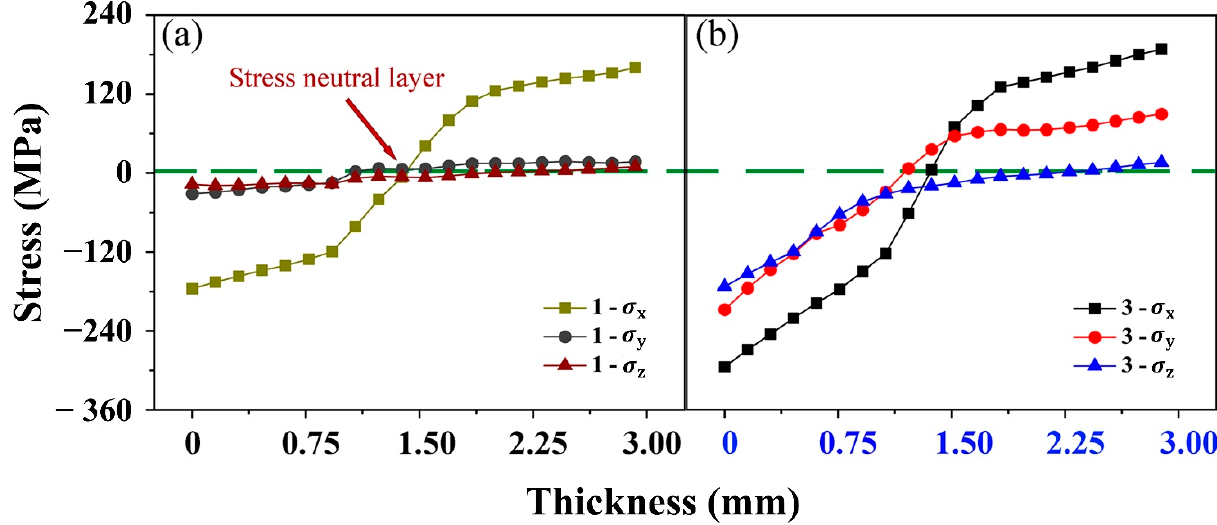
Figure 6. Distributions of 𝜎 (cid:2934) in the LD, TD and ND along path 1 ( a ) and path 3 ( b ).